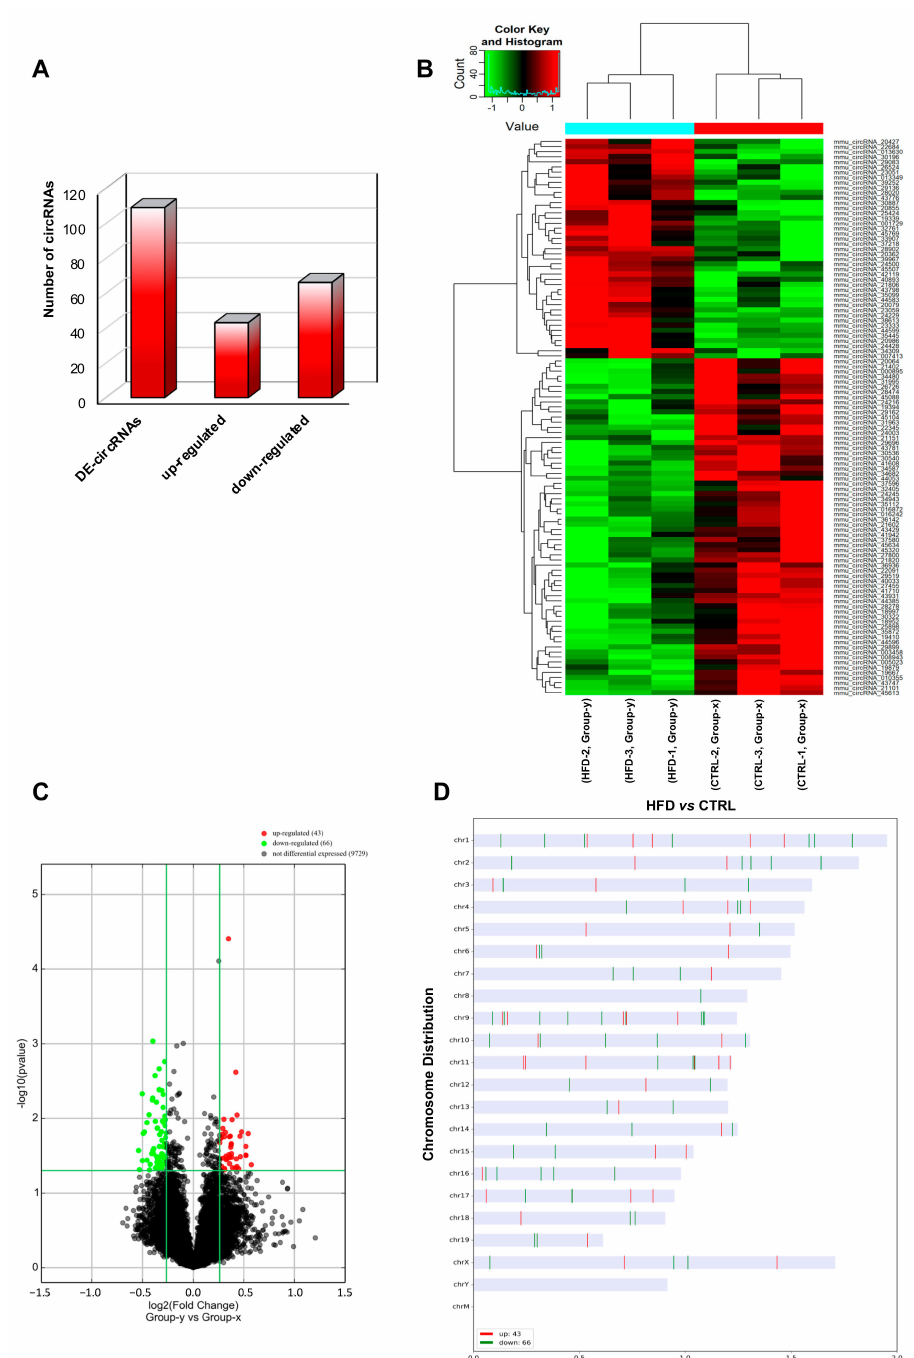
Figure 3. Differential expression of circRNAs between CTRL and HFD SPZ. ( A ) The distribution of up- and downregulated DE-circRNAs, among a total of 109 DE-circRNAs, in HFD compared with CTRL SPZ. ( B ) Hierarchical clustering analysis of DE-circRNAs in CTRL SPZ (samples CTRL-1, CTRL-2, CTRL-3) and HFD SPZ (samples HFD-1, HFD-2, HFD-3); the expression values (fold change > 1.5, p < 0.05) were represented in different colors, indicating expression levels above and below the median expression level across all samples. ( C ) The volcano plot was constructed using fold change and p -values; in detail, the values on X and Y axes are log2 (FC = fold change) and –log10 ( p -values), respectively. Red points in the volcano plot represent the DE-circRNAs with statistical significance. ( D ) The distribution of up- and downregulated DE-circRNAs in the mouse genome, according to their host gene